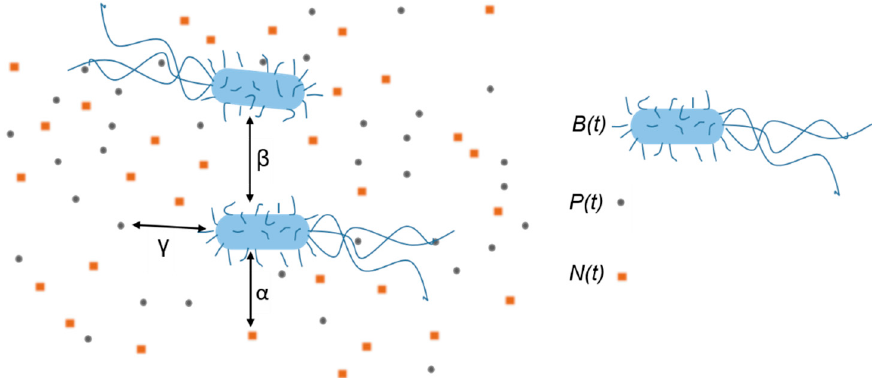
Figure 3. The schematic representation of the batch system as described by our model. The squares and circles represent the nutrients and nanoparticles “packages” that correspond to a single bacterium creation or inactivation, respectively. Interactions are represented by double-head arrows and marked by their interaction strengths α , β , and γ . They describe the following occurrences: Bacteria (i) consume the nutrients, (ii) interact with other bacteria, and (iii) they uptake nanoparticles.